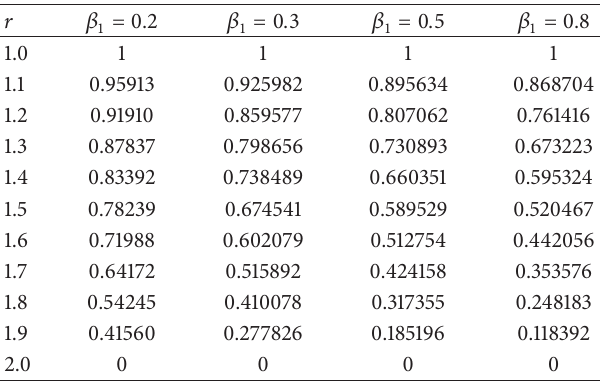
Table 5: Temperature distributions for several values of 𝐵𝑟 1 , when 𝛽